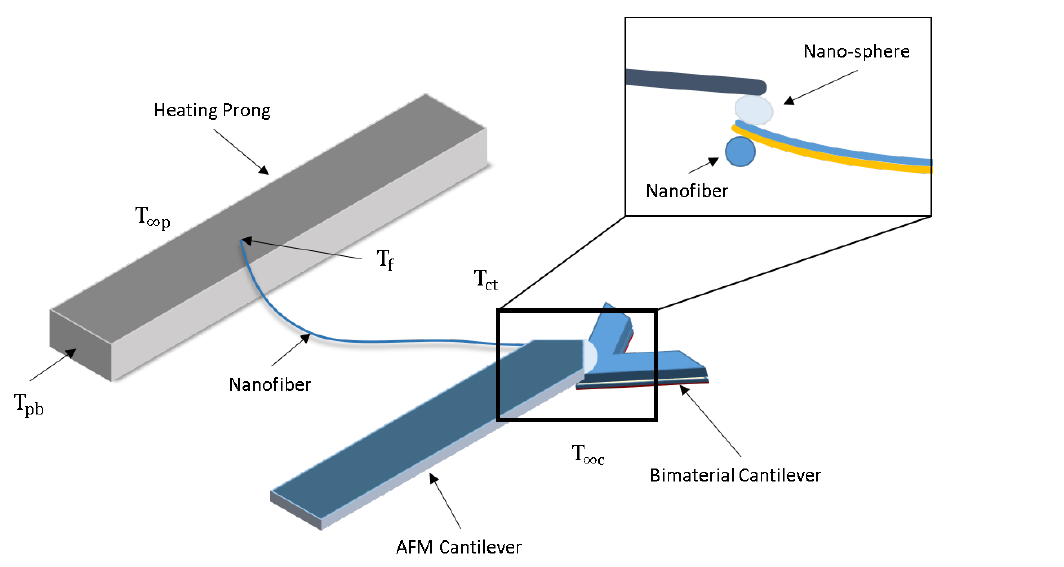
Figure 1. Design and model of the AFM utilizing Probe-to-Probe technique to determine the temperature boundary conditions of nanostructured materials